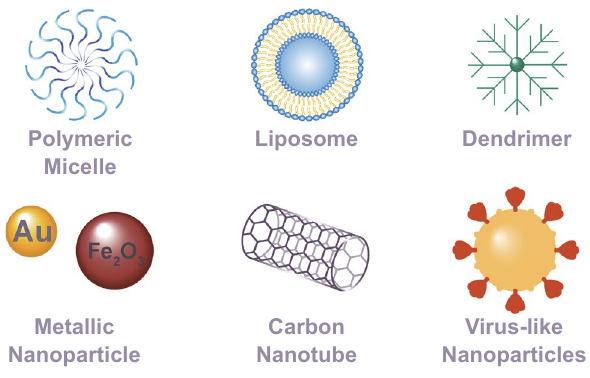
Fig. 3 Schematic representation of the structural composition of dif‑ ferent types of nanoparticles used for vaccine